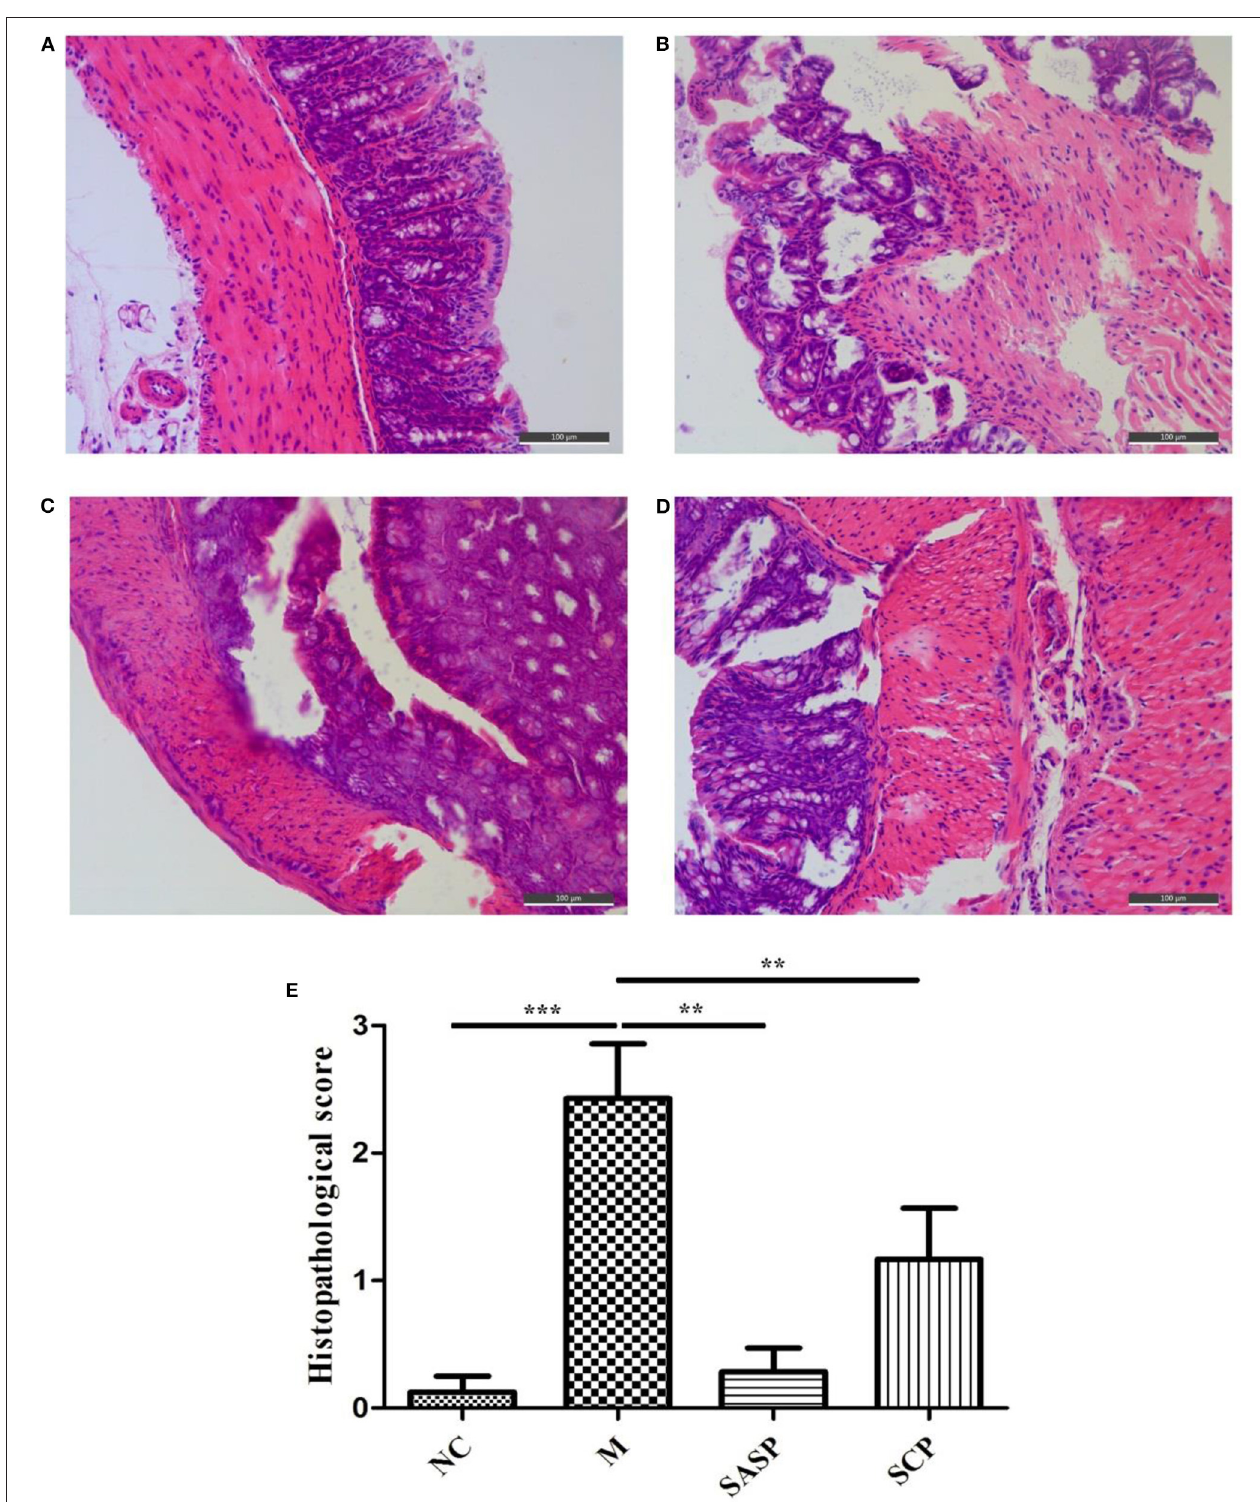
FIGURE 2 | (A–E) Histopathological observation of the Colon. NC, control group; M, DSS group; SASP, positive drug group; SCP, S. chinensis polysaccharide group.